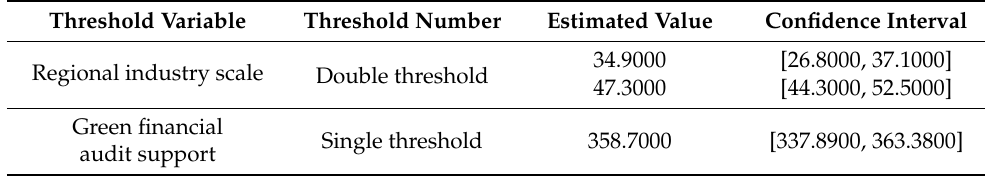
Table 6. Threshold estimates.